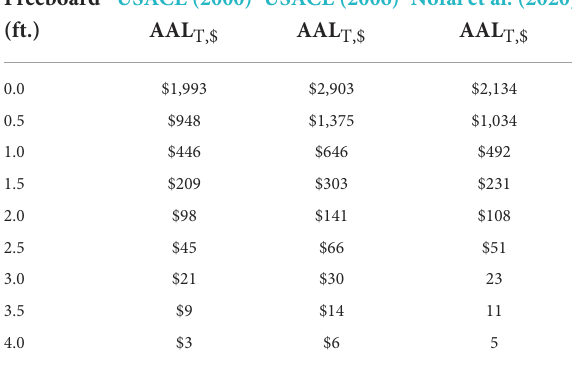
TABLE 4 AAL results using USACE (2000, 2006), and Nofal et al. (2020) at a damage initiation point of − 2 ft relative to FFH. Freeboard USACE (2000) USACE (2006) Nofal et al. (2020) (ft.)